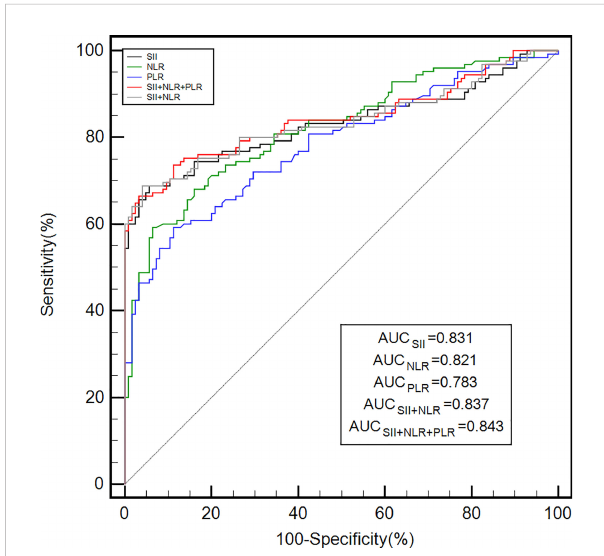
FIGURE 1 The diagnostic ef fi ciency of the PLR, NLR, and SII alone and in combination for gastric cancer was analyzed by ROC curves. ROC, receiver operating characteristic; AUC, area under the ROC curve; PLR, platelet-lymphocyte ratio; NLR, neutrophil-lymphocyte ratio; SII, systemic immune-in fl ammation